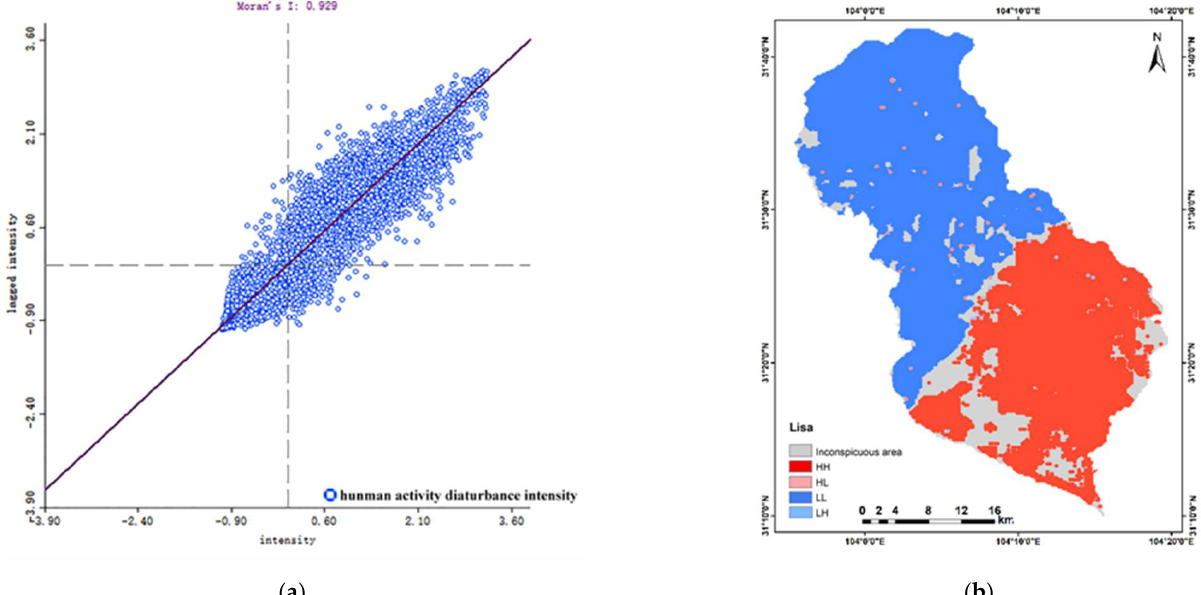
Figure 6. Spatial autocorrelation of human activity disturbance intensity (( a ) Moran scatter plot of human activity disturbance; ( b ) LISA clustering map).